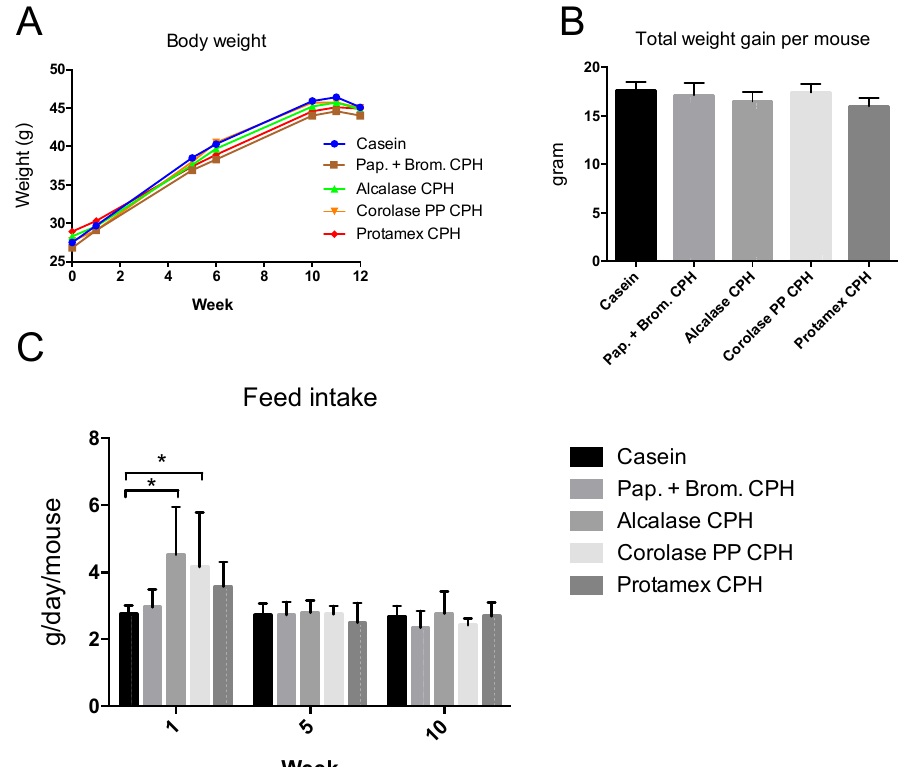
Figure 1. Body weight and feed intake in C57BL/6 mice fed 19 E% casein- or 9.5 E% casein and 9.5 E% CPH-high fat/high sucrose diets for 12 weeks. ( A ) Body weight per mouse measured before and after week 1, 6, and 11, and at day of sacrifice. Mean values are shown ( n = 12). ( B ) Total weight gain per mouse during the study. Mean values with standard deviations are shown ( n = 12). ( C ) Feed intake per week per mouse measured during week 1, 6, and 11 of the study. Mean values were based on average feed intake per mouse per cage ( n = 3). Significant difference between values were determined by one-way ANOVA with Fisher’s LSD test (* p < 0.05).